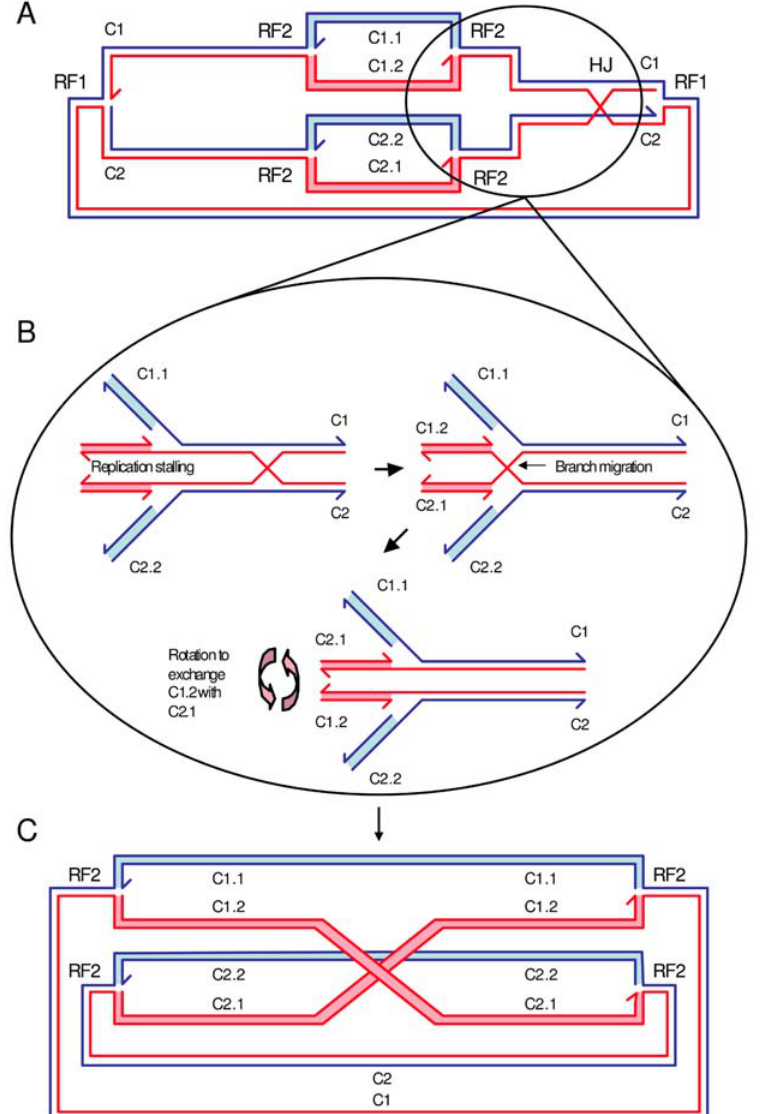
Figure 7. Model for the generation of chromosome dimers without Holliday junction cleavage-ligation. Bacteria, such as E. coli , have circular chromosomes and at normal growth rates reinitiate DNA replication before the previous round of replication has completed and before cell division takes place. This means that an unresolved Holliday junction is a potential barrier to the passage of the next set of replication forks. We propose here that replication through the Holliday junction may be possible and that this may be facilitated by the branch migration protein RecG. A. Chromosome in which a Holliday junction (HJ) has formed following the passage of a replication fork (RF1). A second pair of replication forks (RF2) are shown approaching the Holliday junction. The first two chromosomes to be produced by this replicating structure are labelled C1 and C2. The two chromosomes destined to be made from C1 are labelled C1.1 and C1.2 and the chromosomes destined to be made from C2 are labelled C2.1 and C2.2. The DNA strands that have exchanged to form the Holliday junction (and strands templated on these) are shown in red whereas the DNA strands that have not exchanged (and strands templated on these) are shown in blue. The four double-stranded molecules formed by the second pair of replication forks are shaded in light blue and pink. B. Two new forks (RF2) approaching the Holliday junction. When the pair of RF2 forks approaches the Holliday junction, the positive supercoiling ahead of the forks is predicted to push the junction ahead of them. At some point the forks are likely to stall, presumably because the Holliday junction impedes their progression. At this point, branch migration of the Holliday junction to the fork will lead to a swapping of newly synthesised sister chromosome arms. Chromosomes C1.1 and C2.1 will be connected to the unreplicated arm of C1 while chromosomes C1.2 and C2.2 will be connected to the unreplicated arm of C2. C. Formation of two monomeric and one dimeric chromosome. The replication machinery is reassembled on the two hybrid RF2 forks and replication continues. The figure illustrates the point where the RF2 forks have passed through the Holliday junction leaving the red strands crossed over (CO). The RF1 forks have completed their replication and no longer exist. When the RF2 forks complete replication and meet at the terminus, two monomeic blue chromosomes (C1.1 and C2.2) will have formed as well as one dimeric red (crossover) chromosome (C1.2–C2.1). The shading of the molecules formed by the RF2 replication forks illustrates that the red double strands are crossed over whereas the blue double strands are not.